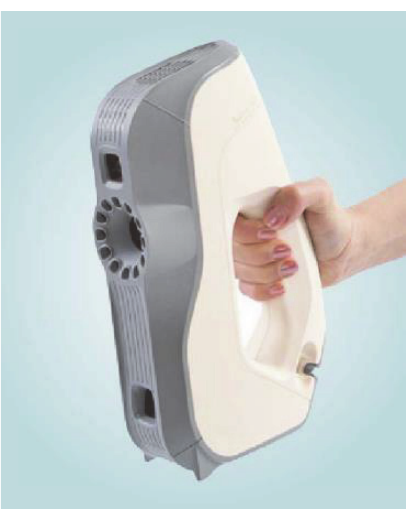
Figure 1: A portable Artec 3D laser scanner.